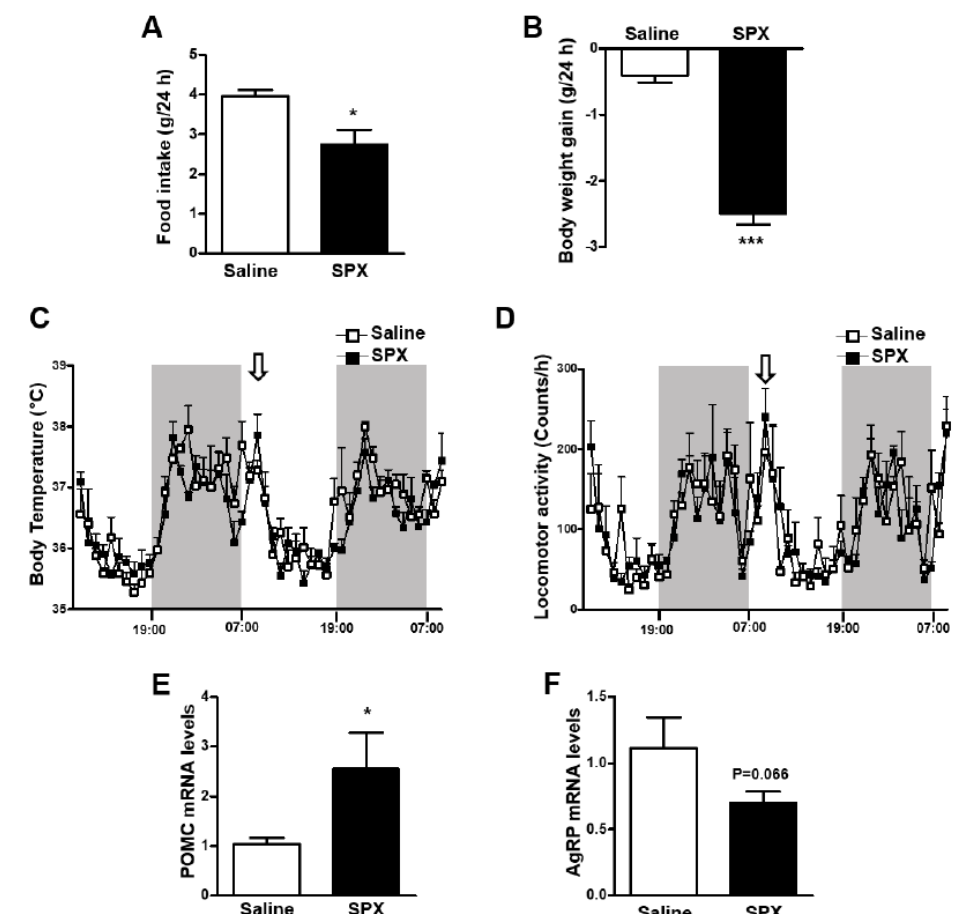
Figure 1. Effects of icv SPX administration on food intake, body weight and POMC and AgRP mRNA levels. Eight-week-old male mice were icv-injected with saline or SPX (10 μg). Food intake ( A ) and body weight gain ( B ) were measured for 24 h after injection. Body temperature ( C ) and locomotor activity ( D ) were observed for 48 h using a vital-view telemetry system. SPX was injected at the beginning of light period as indicated with arrows. Shaded areas represent the dark period. No difference was observed between injection with saline and SPX (n = 4/group). POMC ( E ) and AgRP ( F ) mRNA levels were assessed by qRT-PCR analysis. Data are presented as mean ± S.E.M. *, p < 0.05; ***, p < 0.001.